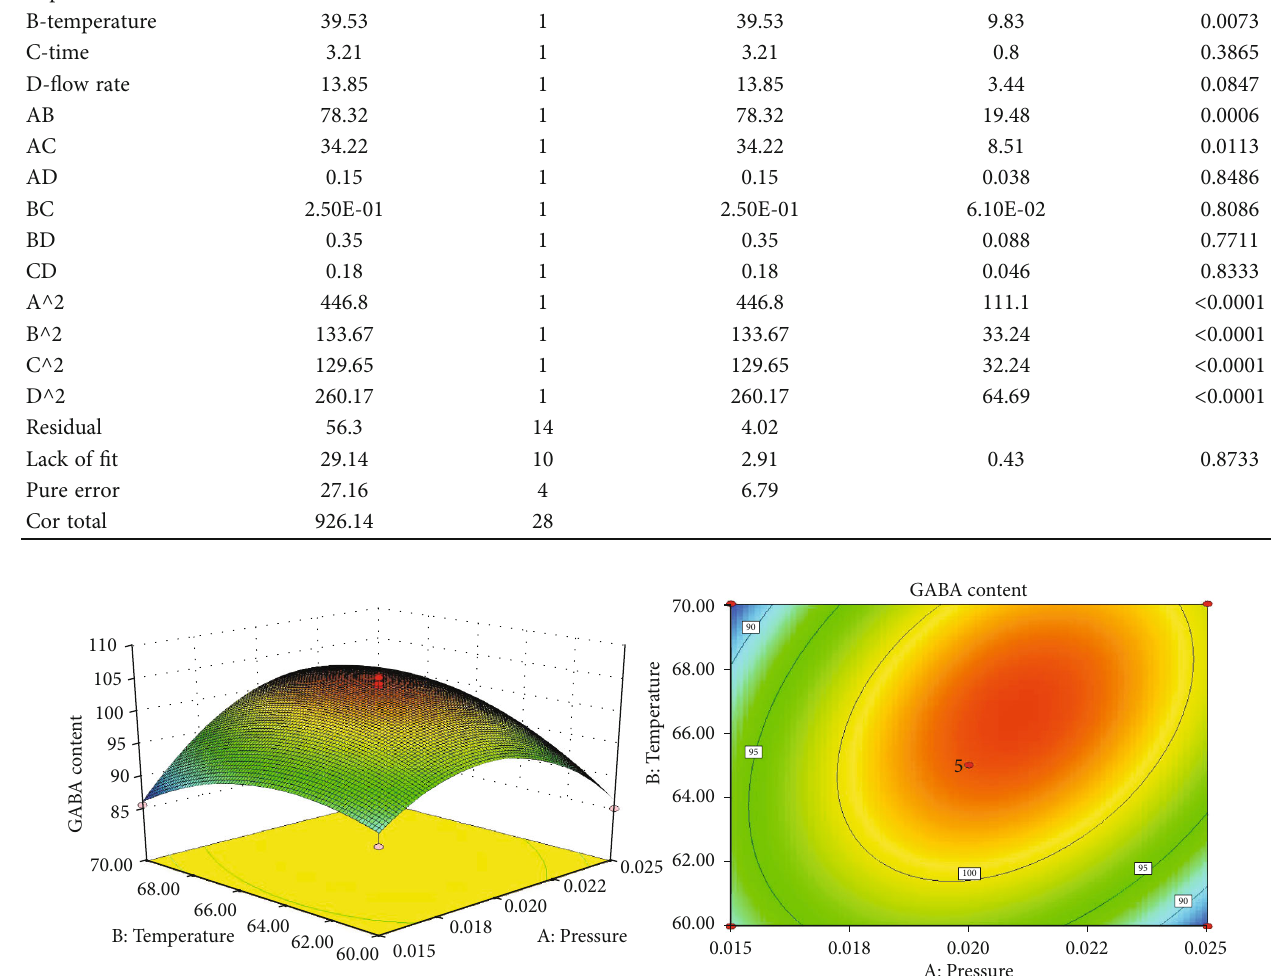
Figure 16: Response surface and contour diagram of pressure and temperature in fl uence on GABA content.